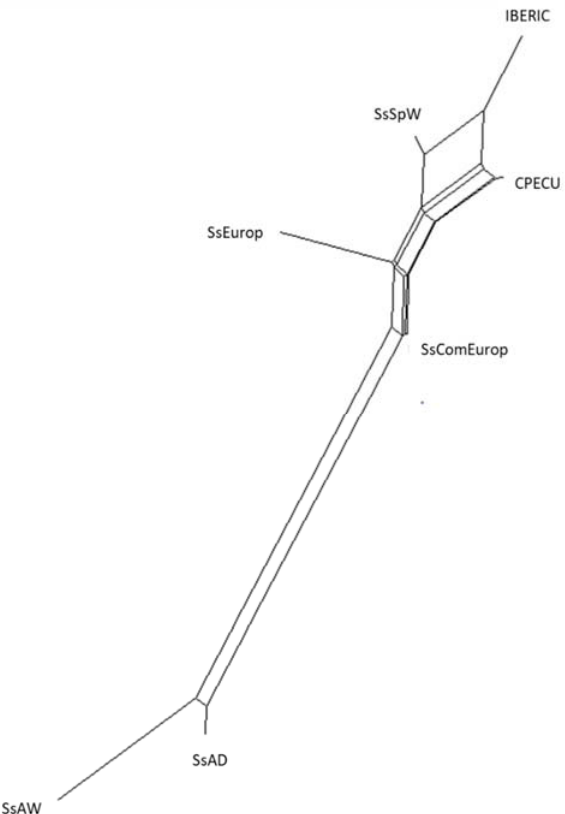
Figure 1. Neighbor-net graph drawn by different populations and 134 pig mitochondrial sequences studied by using the splits tree 4.0 program. CPECU: Pillareño; SsEurop: European domestic pigs; IBERIC: Spanish Iberic pigs; SsComEurop: Commercial European pigs; SsAD: Asian domestic pig; SsSpW: Spanish wild pig; SsAW: Asian wild pig. Table 1. Variable positions in mtDNA D-loop in Pillareño Creole pig (CPECU). Sequence identities (“.”) and deletions are indicated by dots and dashes. Nucleotide positions are numbered according to the reference sequence GenBank AJ002189 [2]. Nucleotide Table 4. Coancestry coefficient indices for each population studied.